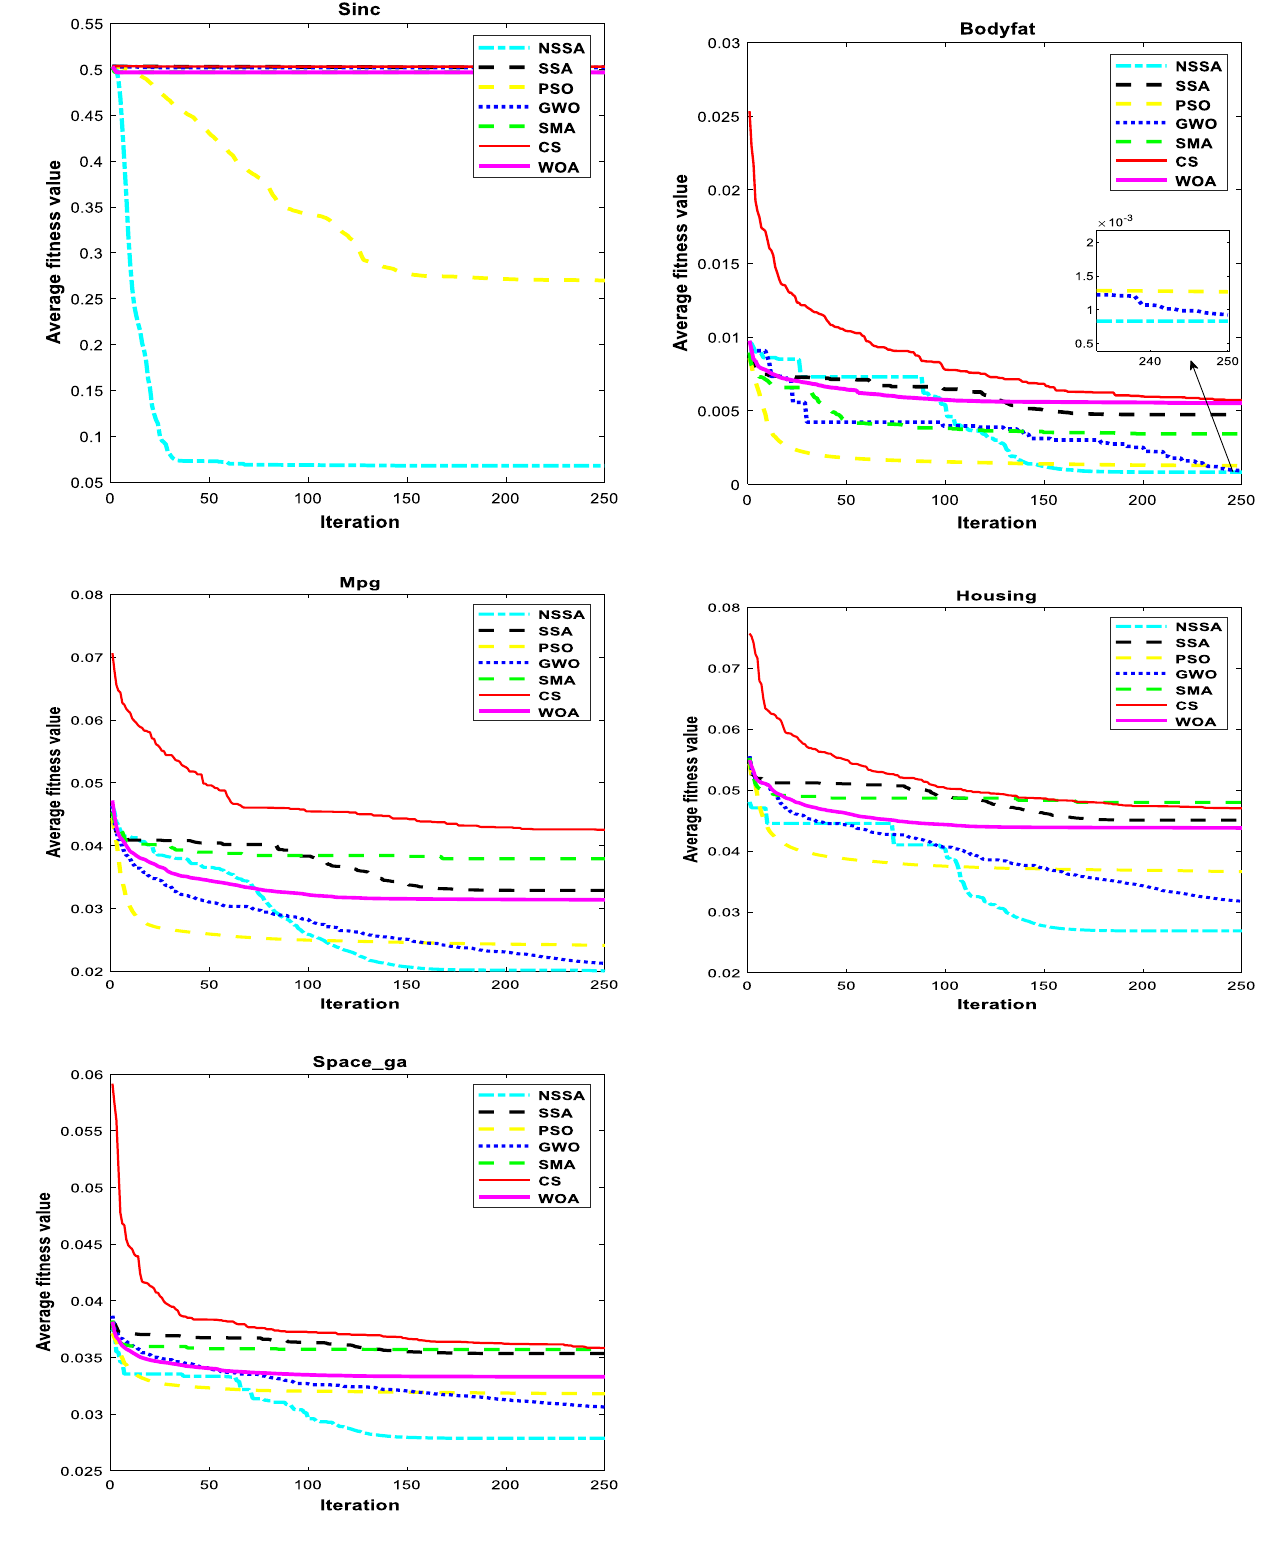
Fig. 6 Average iteration curve during regression